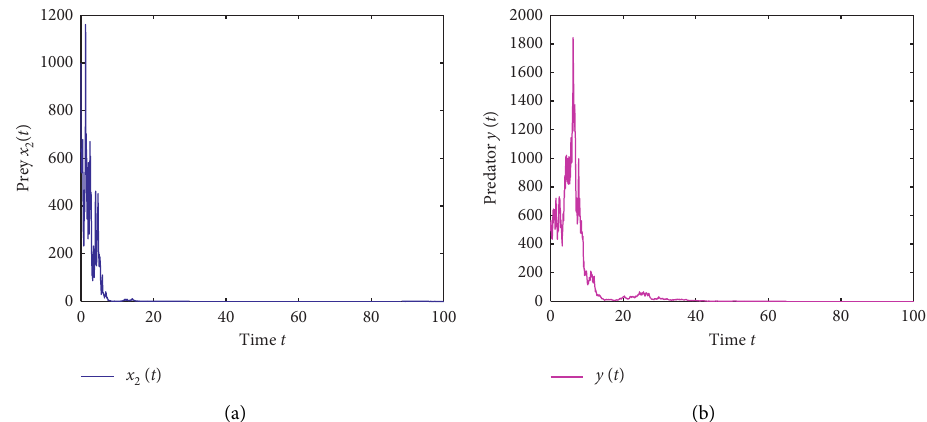
Figure 15: The trajectories of (5) with σ 2 (b) predator y ( t ) .